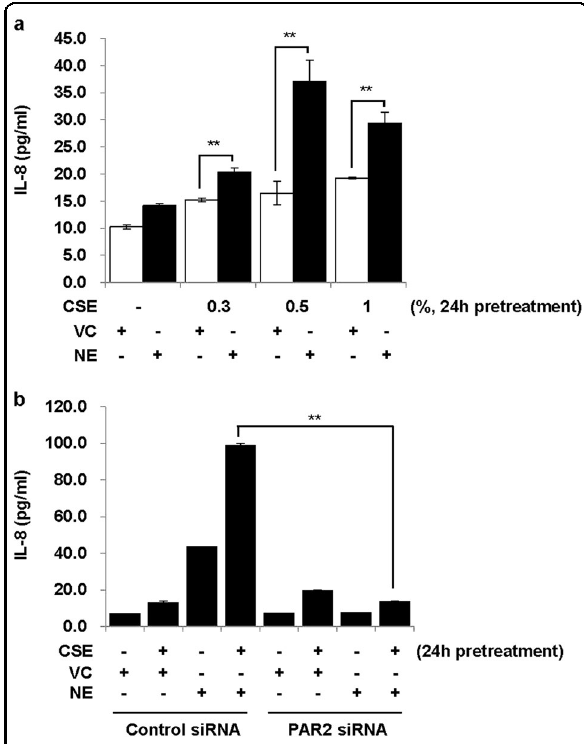
Fig. 2 Pre-treatment with CSE enhances NE-induced IL-8 production via PAR2. a BEAS-2B cells were pre-treated with CSE (0.3, 0.5, and 1%) for 24 h and then stimulated with VC or NE (1 U/ml) for 24 h in the absence of CSE. b Cells were transiently transfected with control siRNAs or PAR2 siRNAs. Forty-eight hours after transfection, cells were pre-treated with CSE (1%) for 24 h and then stimulated with VC or NE (1 U/ml) for 24 h in the absence of CSE. IL-8 concentrations in cell supernatants were measured by multiplex bead assay. Data represent the mean ± SD; ** P <